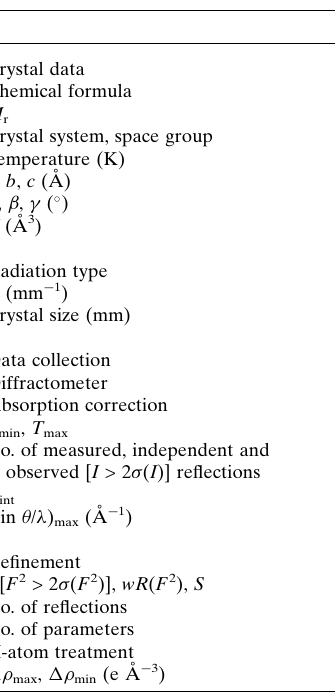
Table 1 Experimental details.